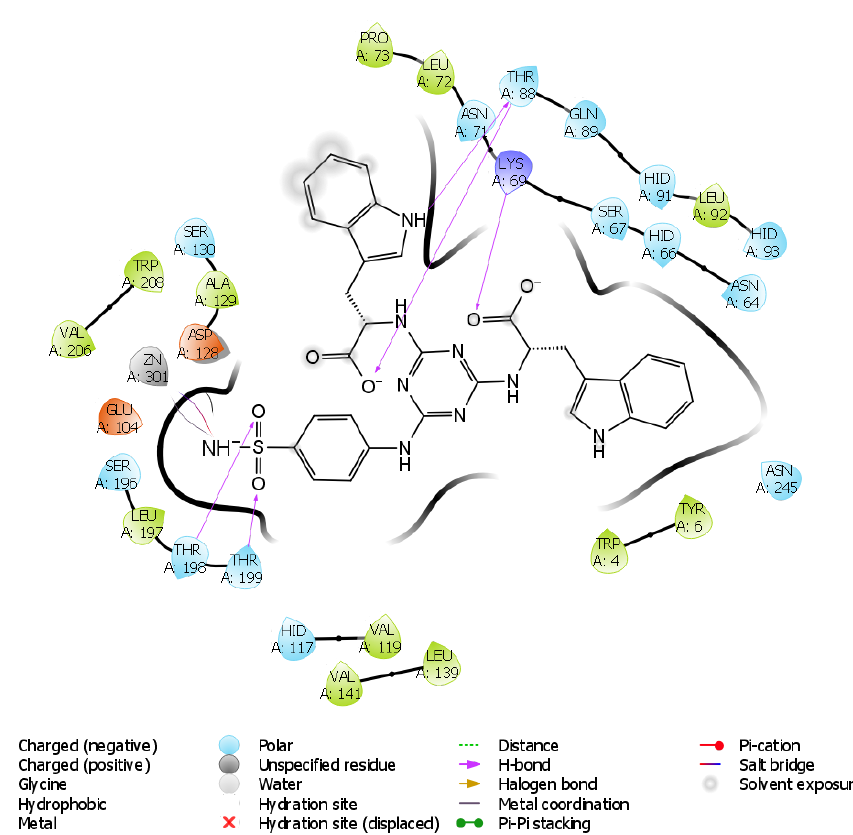
Figure 6. Intermolecular interactions of compound 6 (Trp derivative) docked into hCA XII.